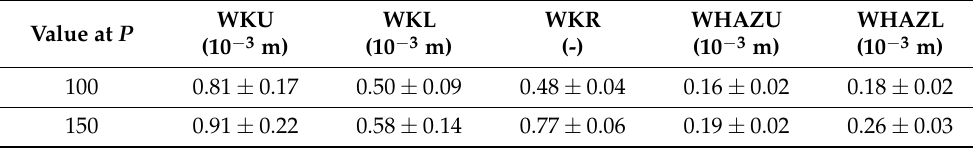
Table 1. Descriptive statistics of all the measured parameters vs. P .